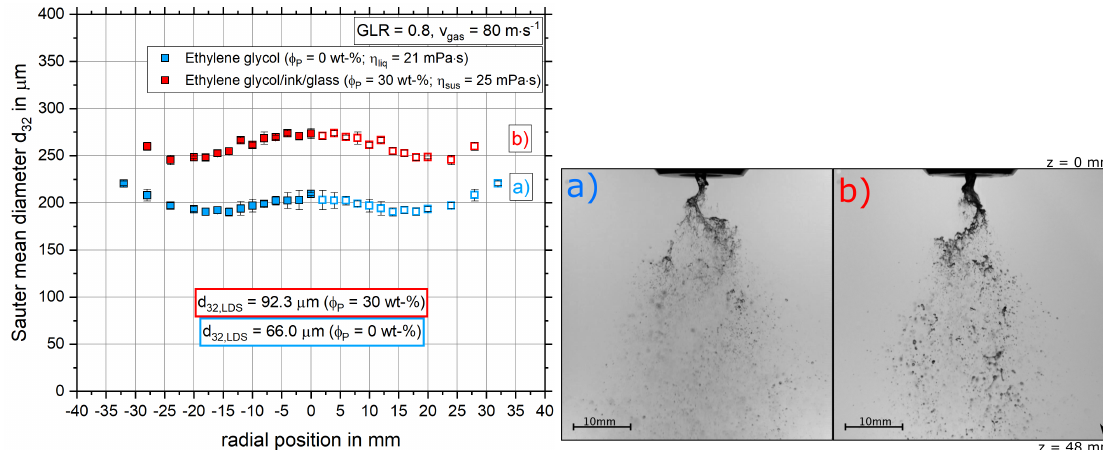
Figure 8. Radial distribution of the Sauter mean diameter at z = 150 mm below the nozzle orifice as a function of the glass mass fraction for v gas = 80 m · s − 1 (dots: SpraySpy R (cid:13) , values: LDS) (left); High-speed camera images of the primary breakup for v gas = 80 m · s − 1 at ( a ) φ P = 0 wt-% and ( b ) φ P = 30 wt-%